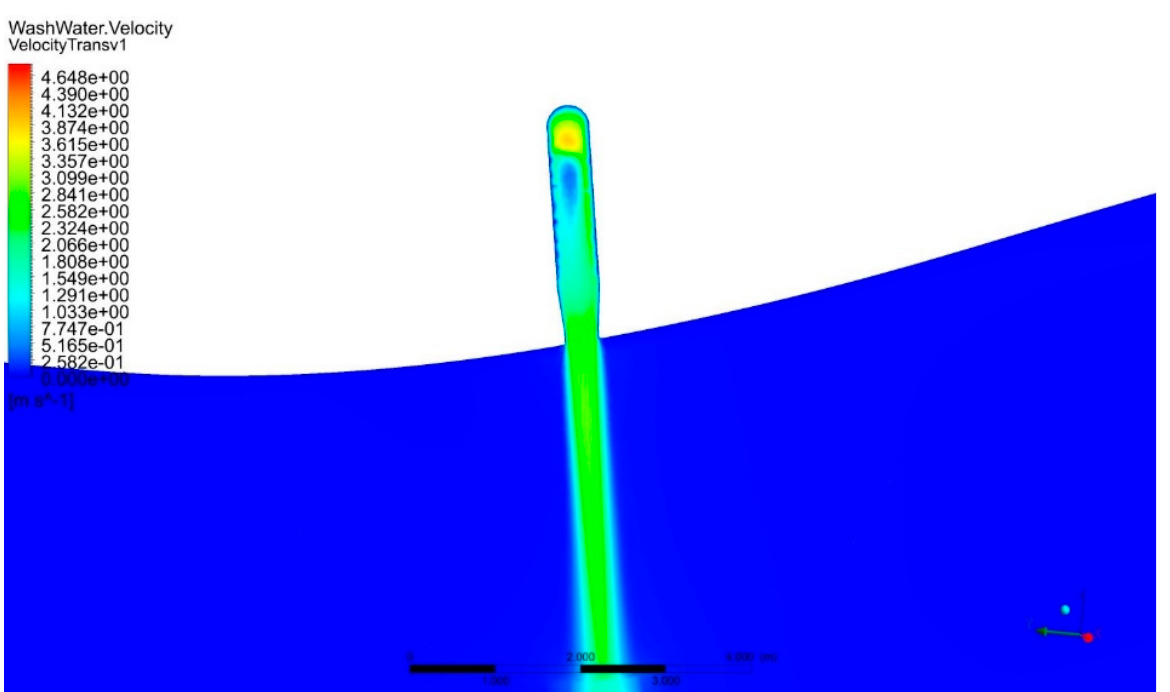
Figure 12. Pressure variation—pipe longitudinal section.